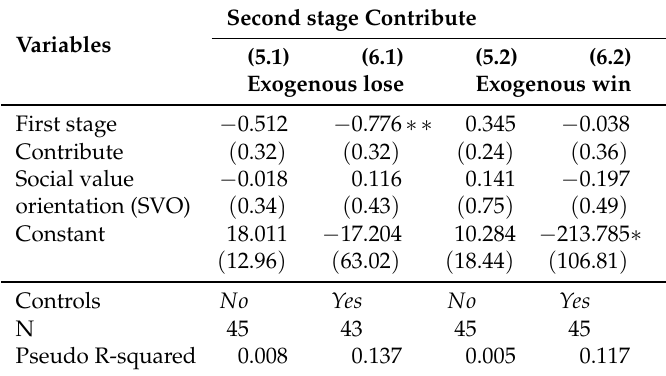
Table A4. Tobit model with limits at 0 and 100 testing if first stage contribution has a significant effect on second stage